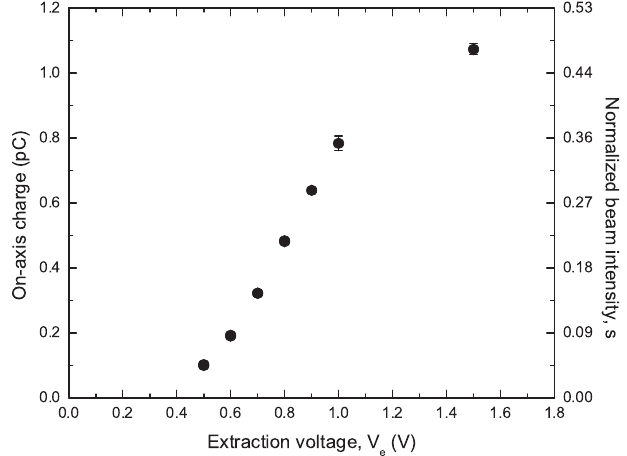
FIG. 5. On-axis charge dependence on the extraction voltage (cid:2) 3 V and V V for V e s